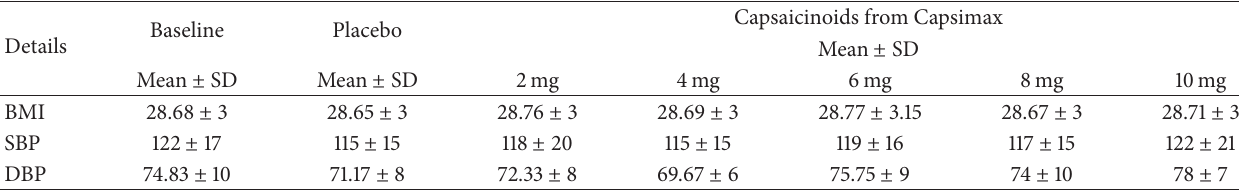
Table 2: Body mass index and blood pressure.